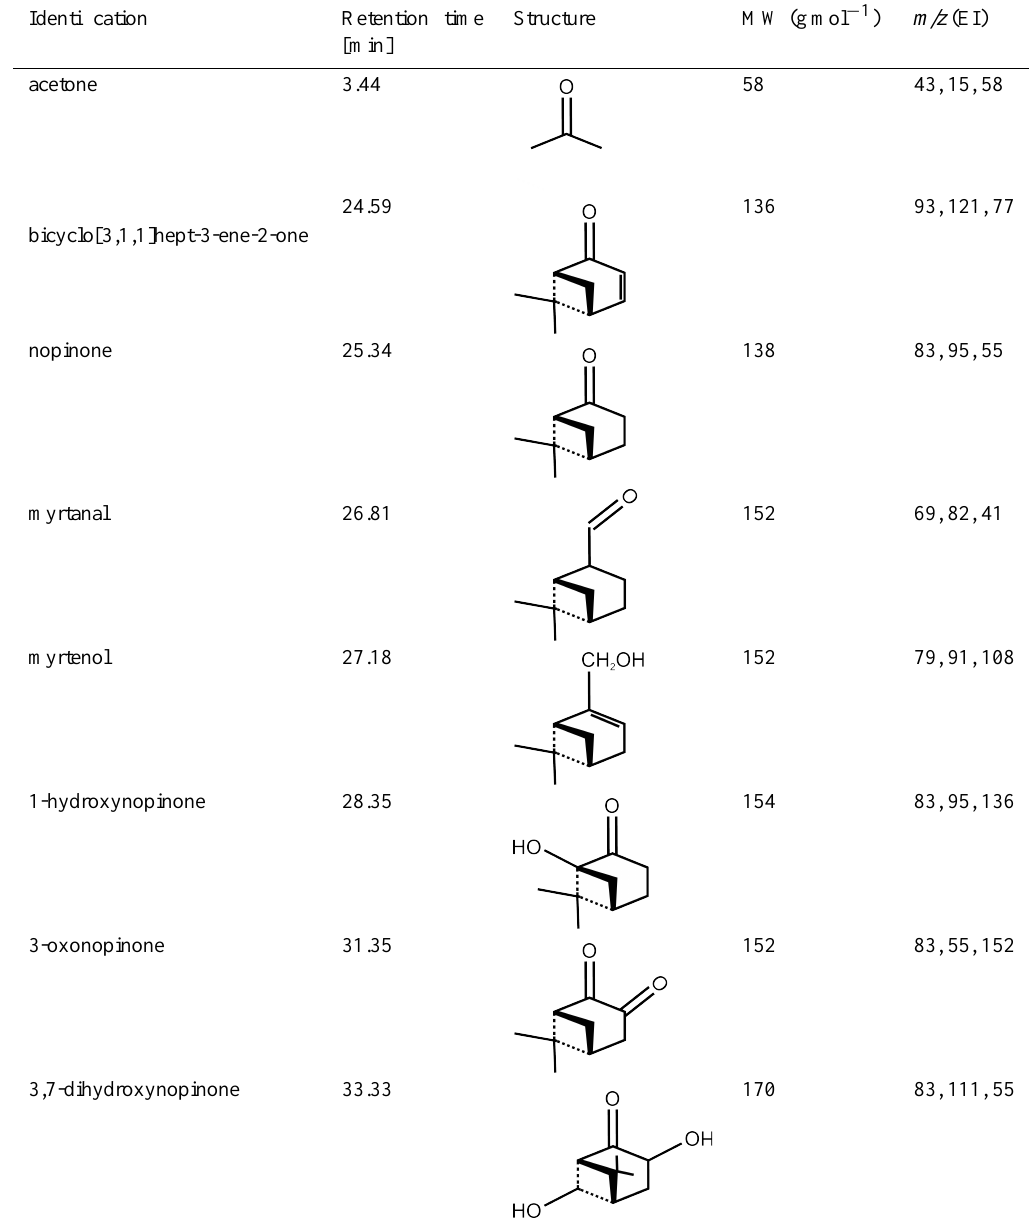
Table 2. Retention time, structure, molecular weight, and m/z of the major ion fragments of the identified products in the β -pinene ozonolysis experiment listed in the order of ascending retention